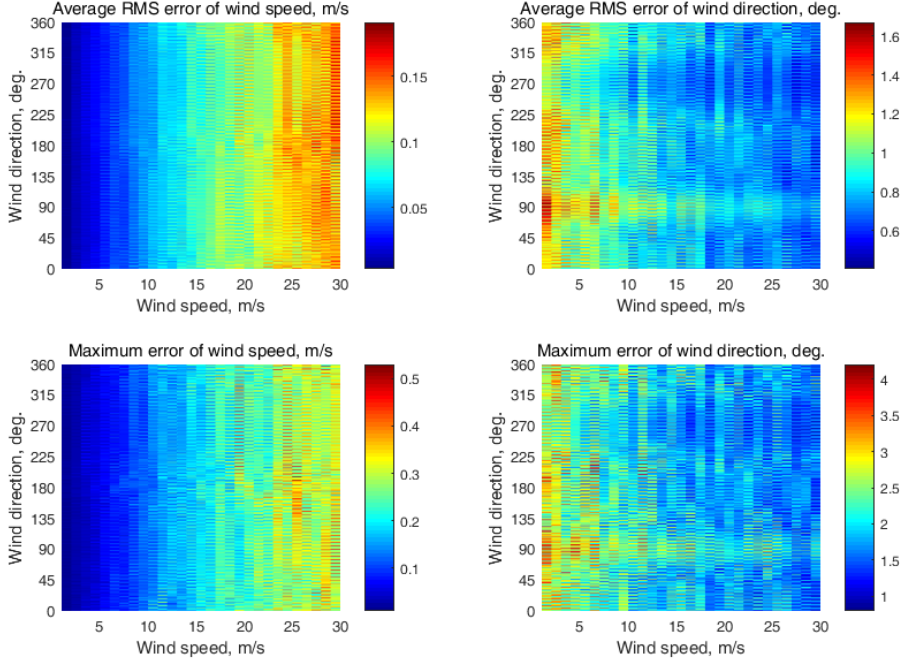
Figure A24. Semicircular wind retrieval results at the (30°, 35°, 40°, 45°, 50°, 55°, 60°) incidence angle combination.